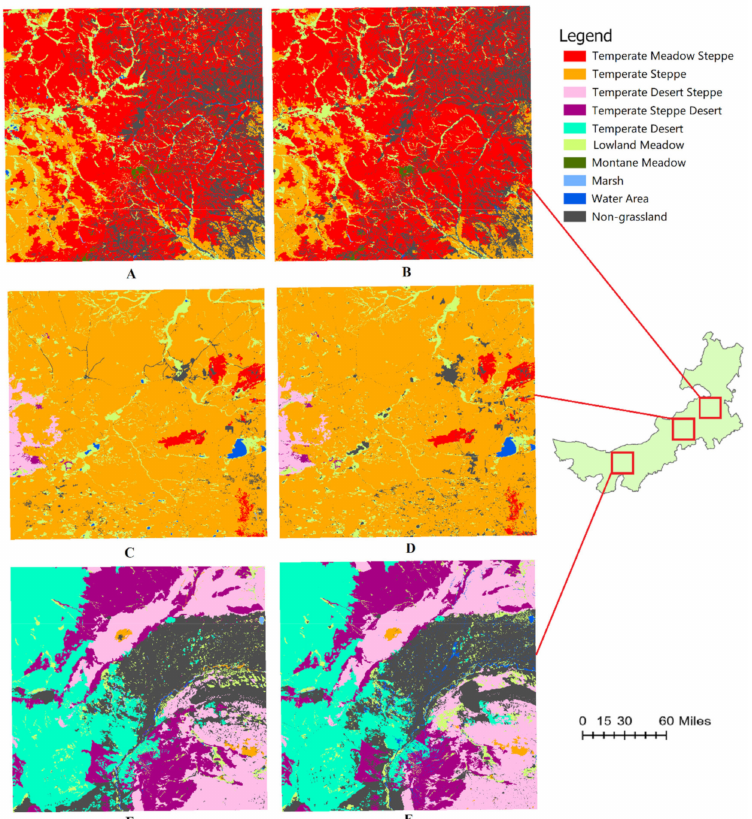
Figure 4. LULC maps of three grassland areas: ( A ) simulated Hinggan League area (meadow grassland), ( B ) real Hinggan League area, ( C ) simulated Xilingol League area (steppe grassland), ( D ) real Xilingol League area, ( E ) simulated Bayan Nur area (desert grassland), and ( F ) real Bayan Nur